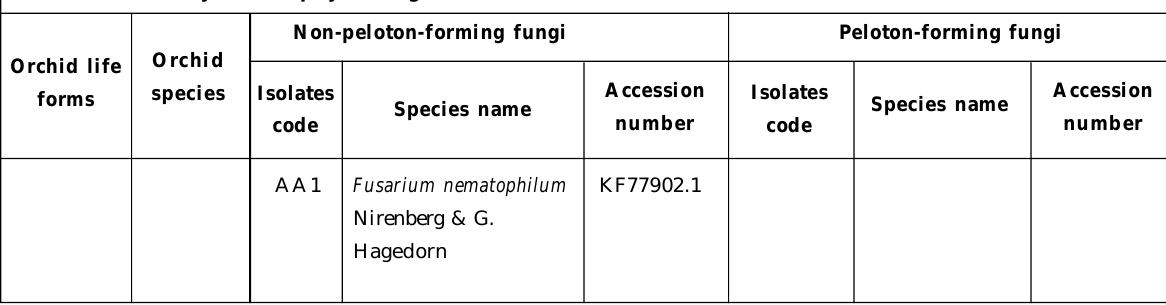
Table 4: Inventory of endophytic fungi in orchids from the MCR